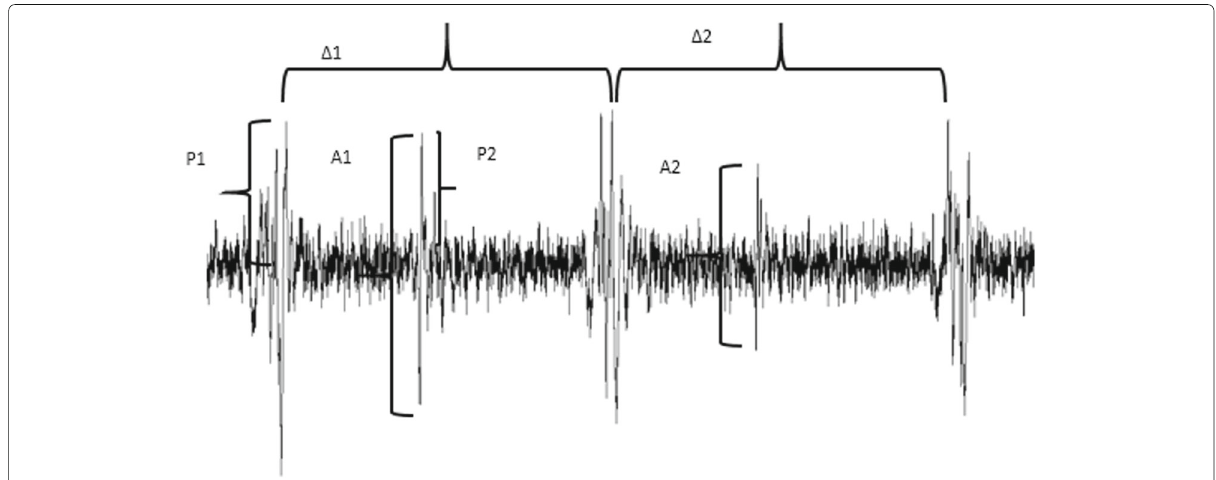
Fig. 5 Analysis of PCG signal in the time domain